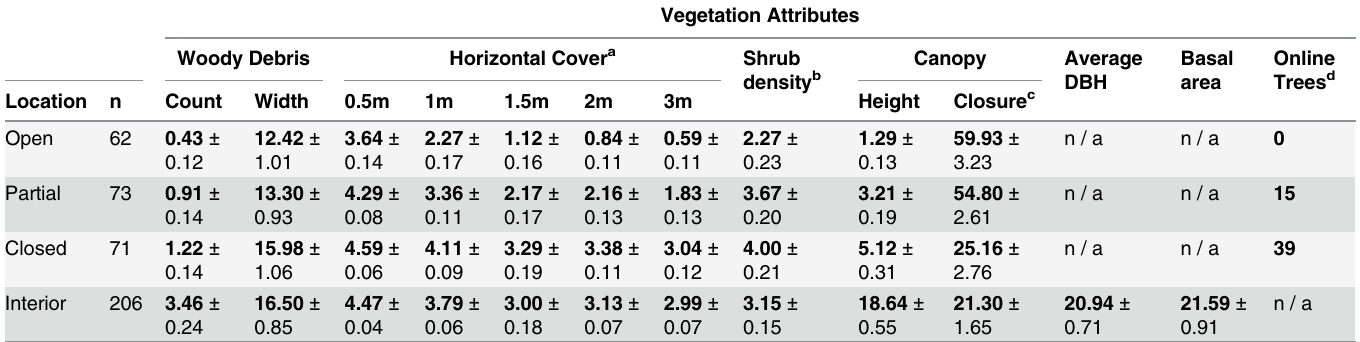
Table 2. Mean values (+/- standard errors ) of vegetation attributes along conventional seismic lines at different stages of recovery (open, partial, closed) and of interior forest (interior) in northwest